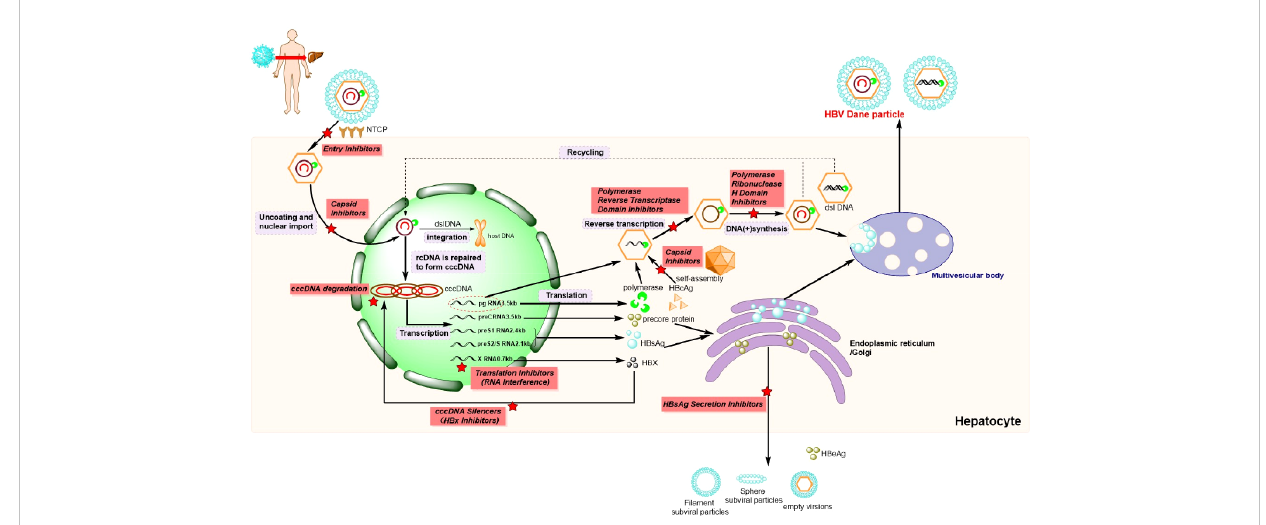
FIGURE 2 Hepatitis B virus (HBV) life cycle and potential drug targets (). HBV, hepatis B virus. NTCP, Na + -taurocholate co-transporting polypeptide; cccDNA, covalently closed circular DNA; rcDNA, relaxed circular DNA; dslDNA, double-stranded linear DNA; pgRNA, polyvalent guide RNA; HBcAg, hepatitis B virus core antigen; HBsAg, hepatitis B surface antigen; HBX, hepatitis B-encoded X antigen; HBeAg, hepatitis Be antigen; cRNA, cytoplasmic RNA.